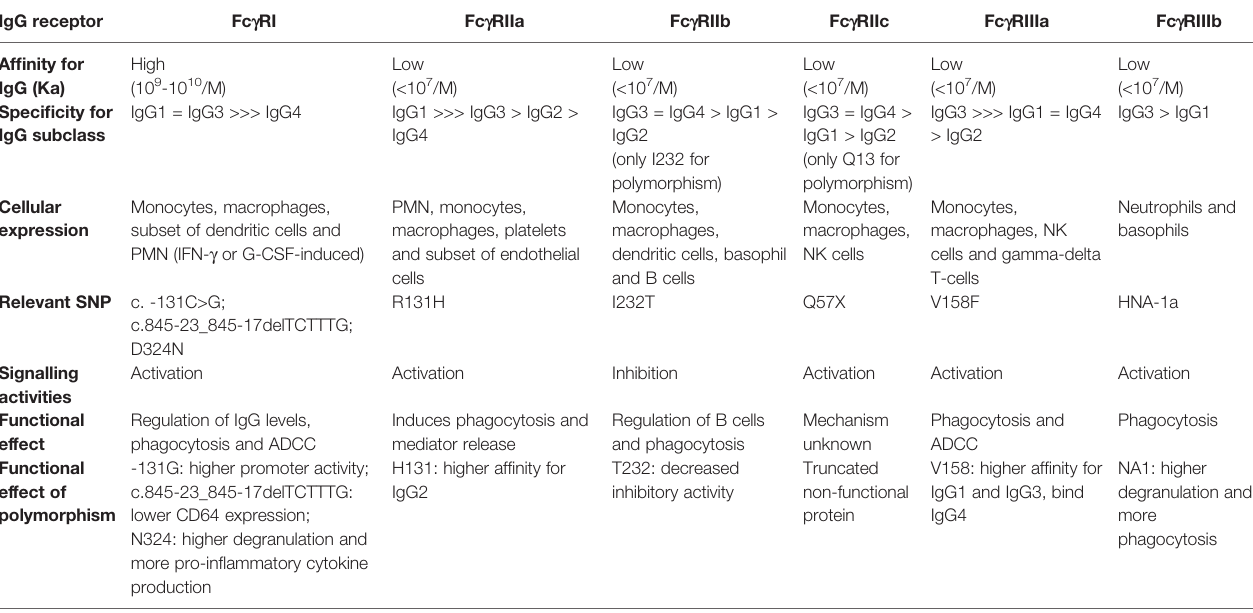
TABLE 2 | Overview of Fc g Rs and their functional effects (Modi fi ed from Bournazos et al. and Bruhns et al.). IgG